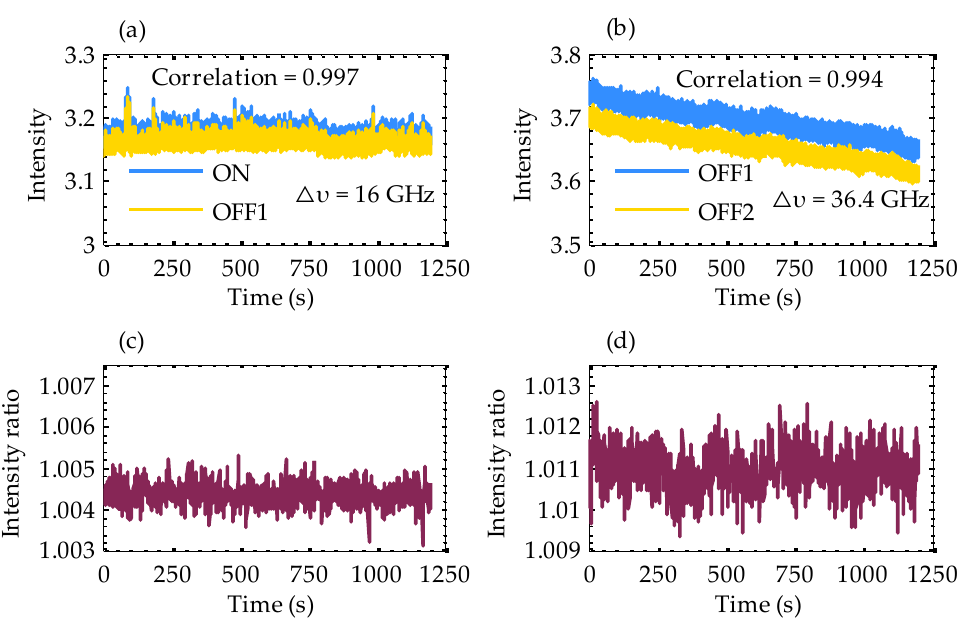
Figure 13. Intensity time-series for di ff erent wavelength separations; ( a ) intensity of on and o ff wavelengths separated by 16 GHz; ( b ) intensity of on and o ff wavelengths separated by 36.4 GHz; ( c ) intensity ratio of time-series in ( a ) after 1 s of smoothing time; ( d ) intensity ratio of time-series in ( b ) after 1 s of smoothing